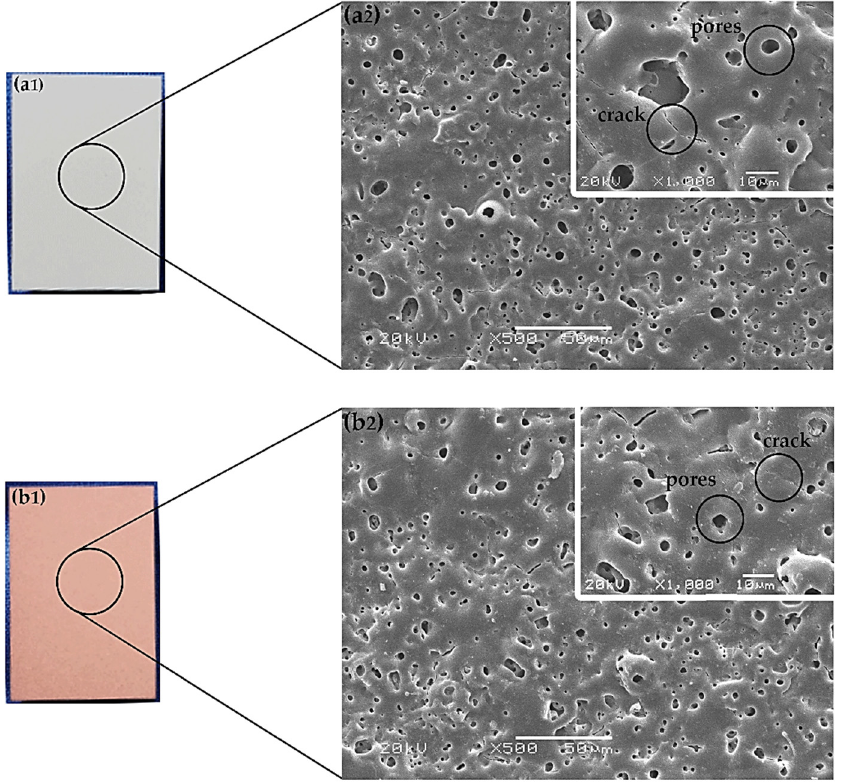
Figure 1. Optical morphology of ( a1 ) MAO / AZ31, and ( b1 ) Cu / MAO / AZ31; SEM morphology of ( a2 ) MAO / AZ31, and ( b2 ) Cu / MAO / AZ31.